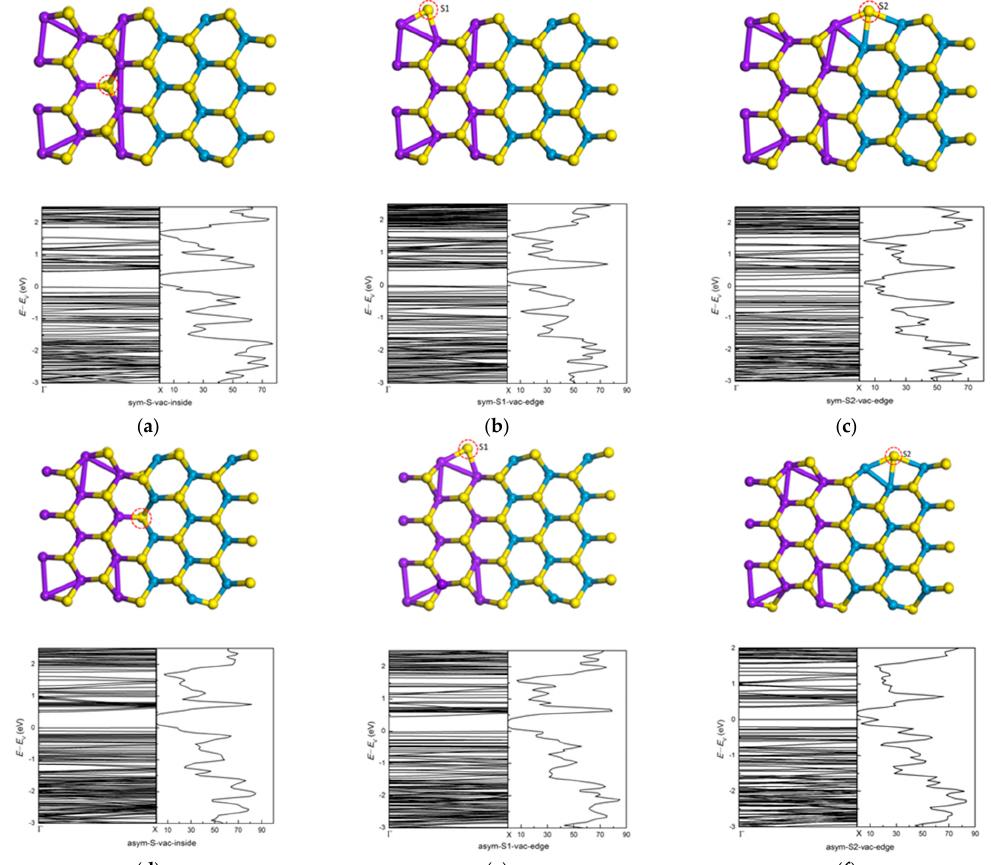
Figure 13. The relaxed geometry, band structure and dos of symmetric and asymmetric (MoS 2 ) 3 /(WS 2 ) 3 armchair nanorib- bons with a S vacancy: ( a ) symmetric structure with inside S vacancy, ( b ) symmetric structure with edge S1 vacancy and ( c ) symmetric structure with edge S2 vacancy, ( d ) asymmetric structure with inside S vacancy, ( e ) asymmetric structure with edge S1 vacancy and ( f ) asymmetric structure with edge S2 vacancy.